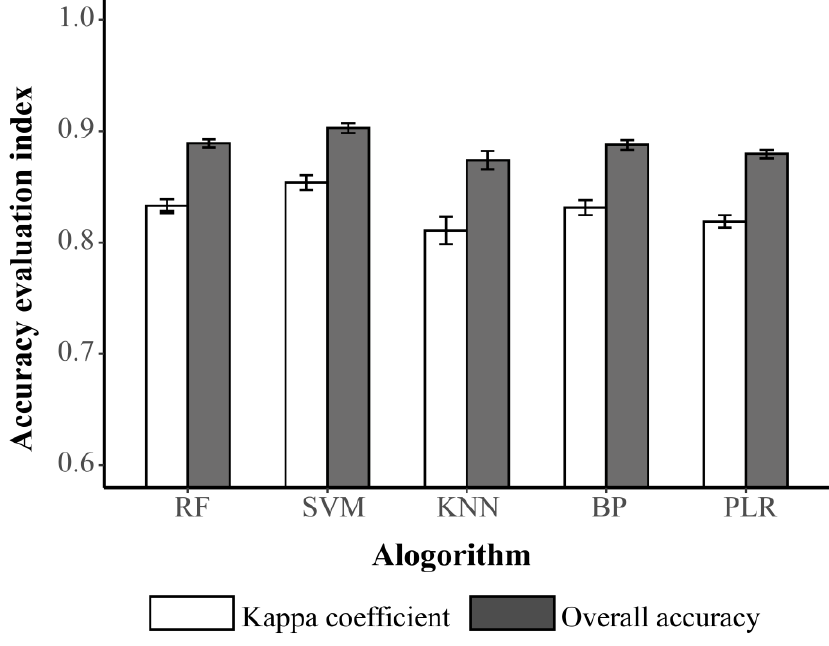
Figure 3. Accuracy comparison of algorithms.